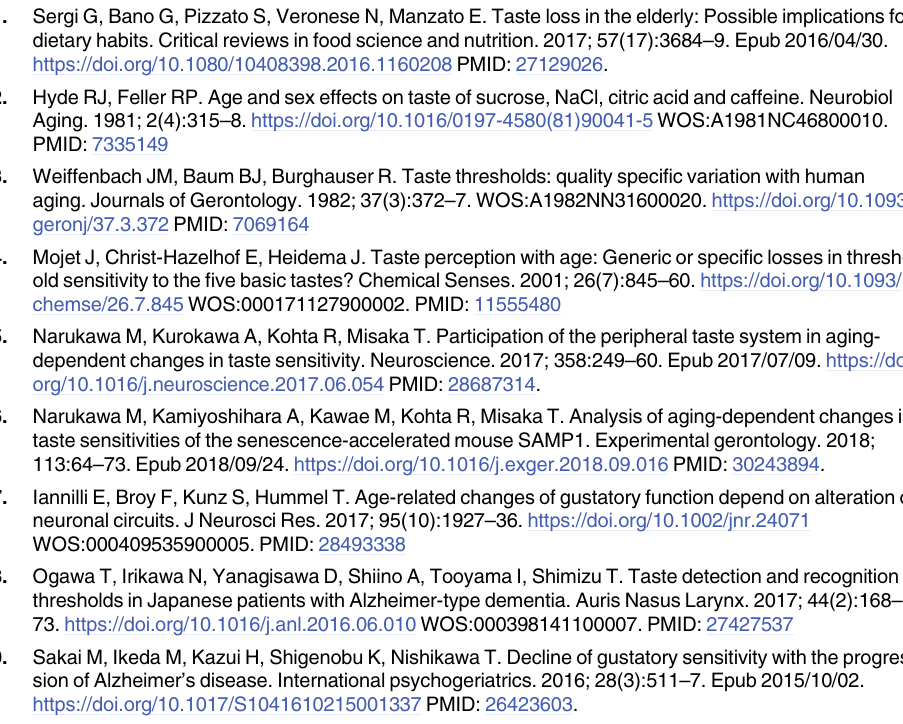
S1 Table. qPCR primer sequences for hippocampus.